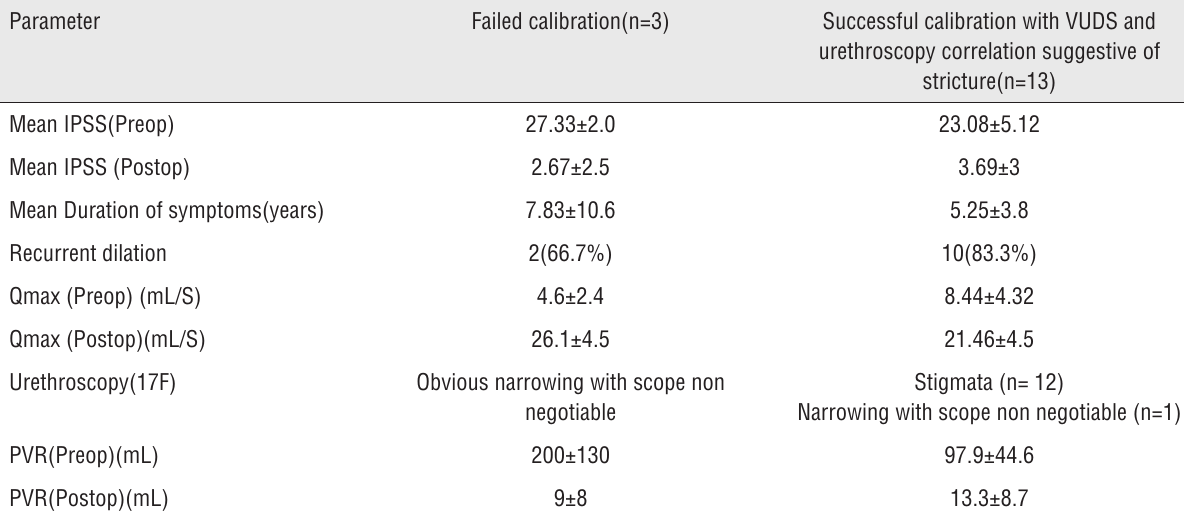
Table 3 - Comparison of various parameters among FUSD with failed and successful calibration(14F) group. Parameter Failed calibration(n=3) Successful calibration with VUDS and